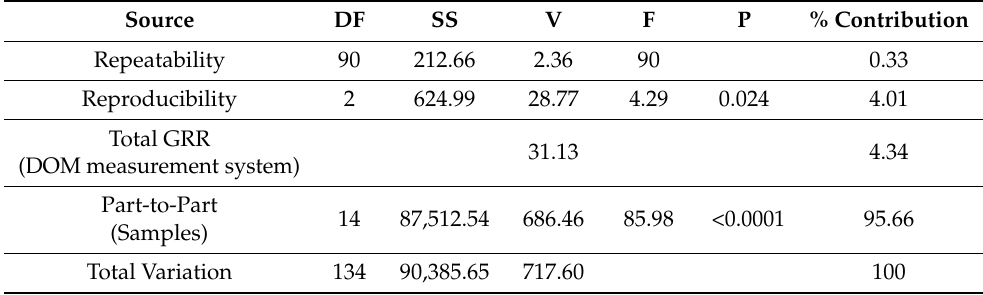
Figure 5. ( a ) Representation of the differences in the marginal analysis (percentage of noncontinuous margins) between the three operators (A, B and C) for all the studied samples (S1–S15, S: sample). ( b ) Box plot showing the variance between operators. The difference between operators is represented by the linearity of the blue line. Operator C has a tendency to overestimate %NCM compared to the two other operators. Horizontal line: median. Boxes: 25–75%. Bars: range of non-outliers. Table 2. Two-way ANOVA table with interaction. Degree of freedom (DF), sum of squares (SS), variance (V), Fisher-test (F), p -value (P), percentage of overall variation from each component (% Contribution), p < 0.05.